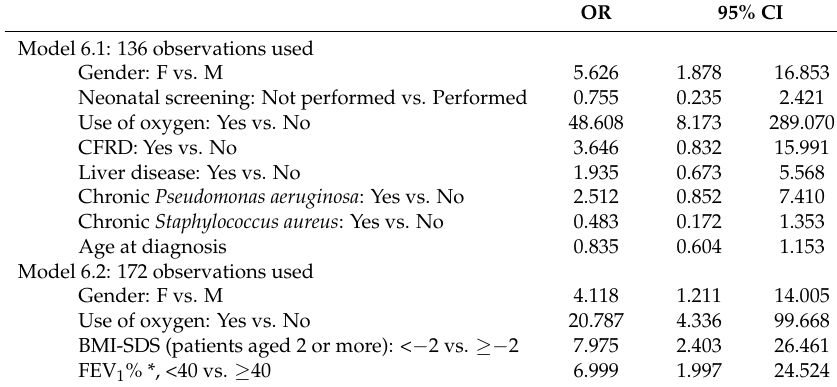
Table 2. Effect of selected factors on mortality in the set of patients under 18, and in the subset of patients 6 to 18 years old.